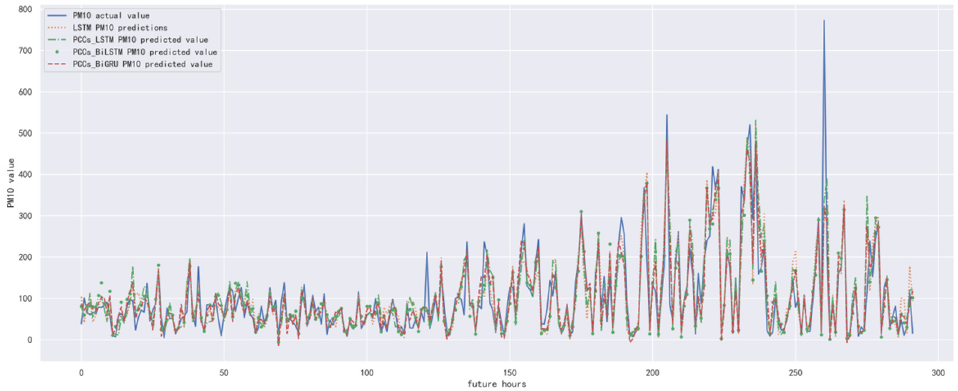
Figure 18. The schematic diagram of predicted PM 10 concentration in the next three hours.